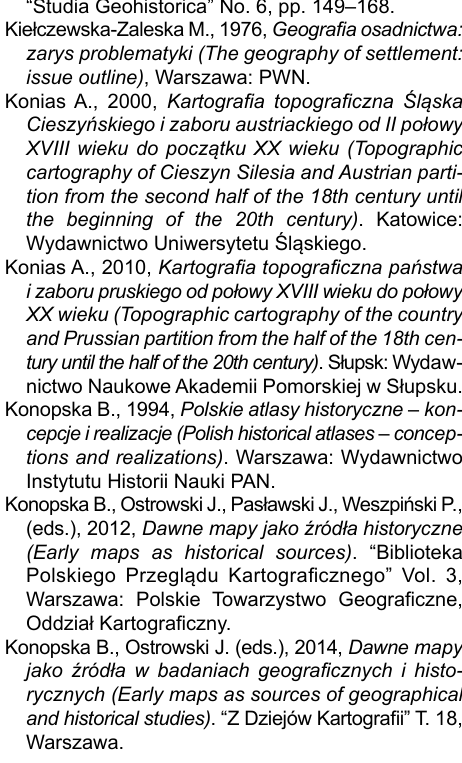
Figlus T., 2016, Zagadnienia morfogenezy i przemian rozplanowania wsi na tle rozwoju osadnictwa w za- chodniej części gminy Szadek (The issues of morphogenesis and changes of village planning in comparison with settlement development in the west part of Szadek commune) . “Biuletyn